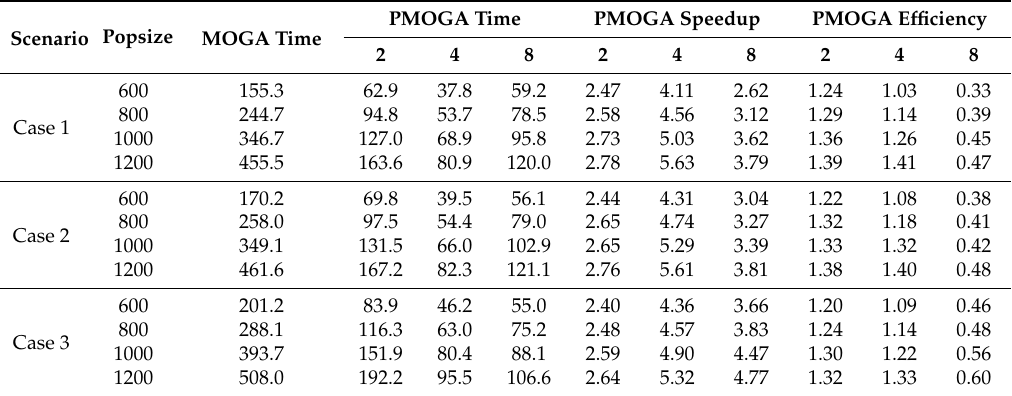
Table 8. Serial and parallel computation time in different cases (time: